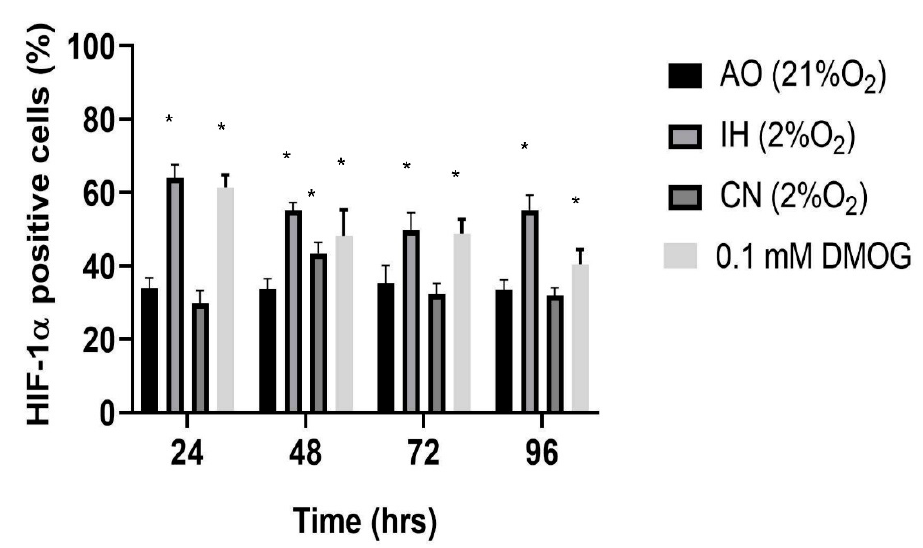
Figure 3. HIF-1 α expression in different oxygen conditions and with DMOG. PC12 cells were incubated under air oxygen (AO), intermittent hypoxia (IH) or continuous normoxia (CN) or with DMOG (0.1 mM) over a 96 h time-course. The percentages of anti-HIF-1 α (ab16066) labelled cells were significantly increased by the DMOG (0.1 mM) and IH compared to corresponding ones in AO; however, the CN did not change the HIF-1 α expression significantly except at 48 h. Data are presented as % of HIF-1 α positive cells ± S.E.M, n = 3. Statistical significance of the assay was evaluated using one-way ANOVA with Tukey post hoc corrections. * indicates significant difference in comparison to the positive cells at zero hour ( p < 0.05).